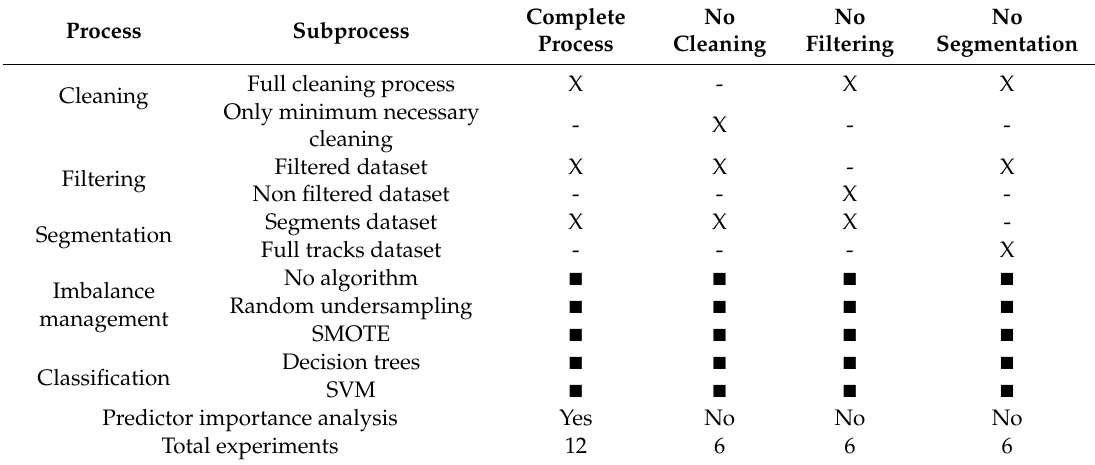
Table 3. Experiments types included